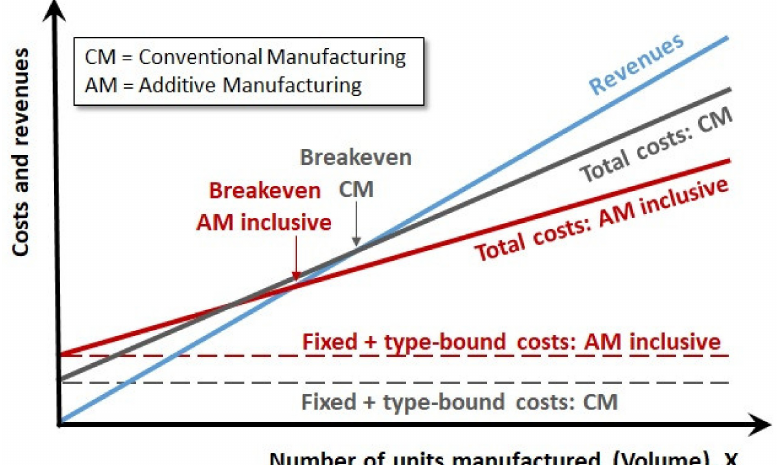
Figure 34. The part costs and revenues: conventional versus AM inclusive fabrication. The lower running AM costs is valid only for the cases in which the tooling enables a shorter cycle time, e.g., conformally cooled injection molding cores